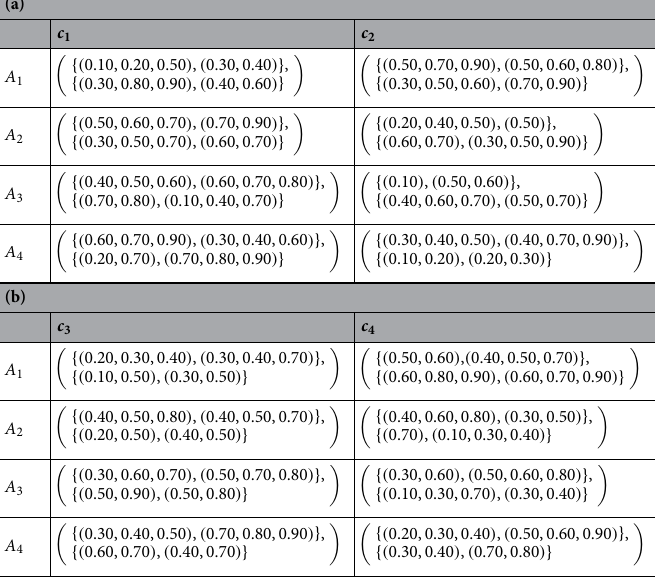
Table 2. Expert-1 information.